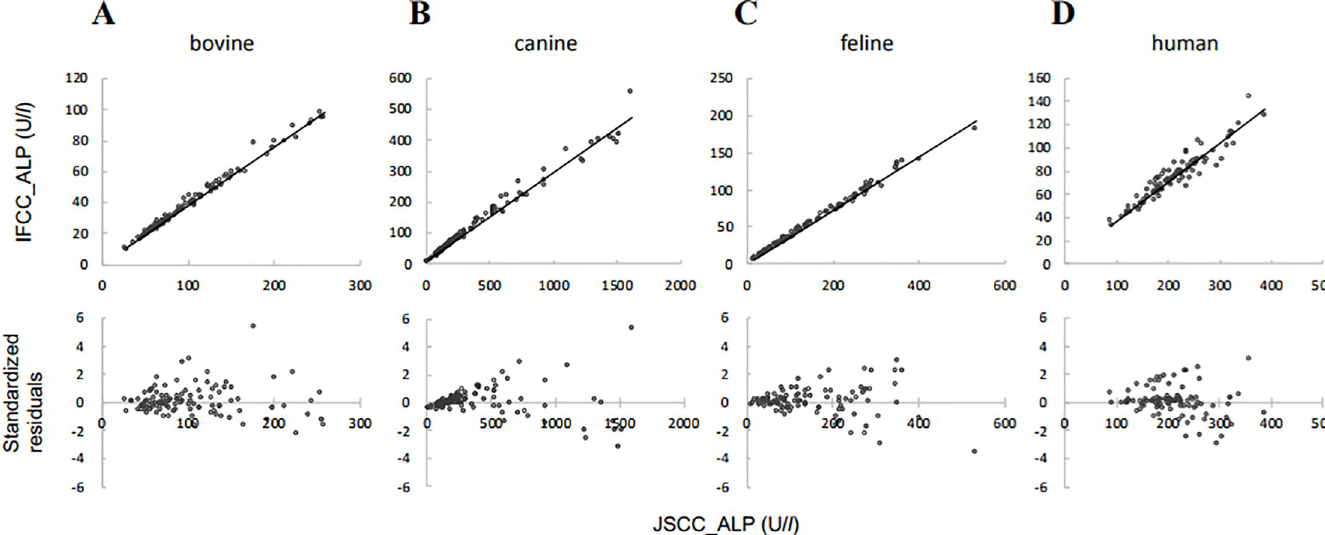
Fig 1. Scatter plots of the blood alkaline phosphatase (ALP) measured by Japan Society of Clinical Chemistry (JSCC) and International Federation of Clinical Chemistry and Laboratory Medicine (IFCC) reference methods and standardized residual plots from the regression formulas. Regression formulas are as follows: (A) 116 bovine specimens, y = 0.379 x + 0.124, (B) 108 canine specimens, y = 0.289 x + 8.291, (C) 103 feline specimens, y = 0.358 x + 0.432, (D) 100 human specimens, y = 0.337 x +